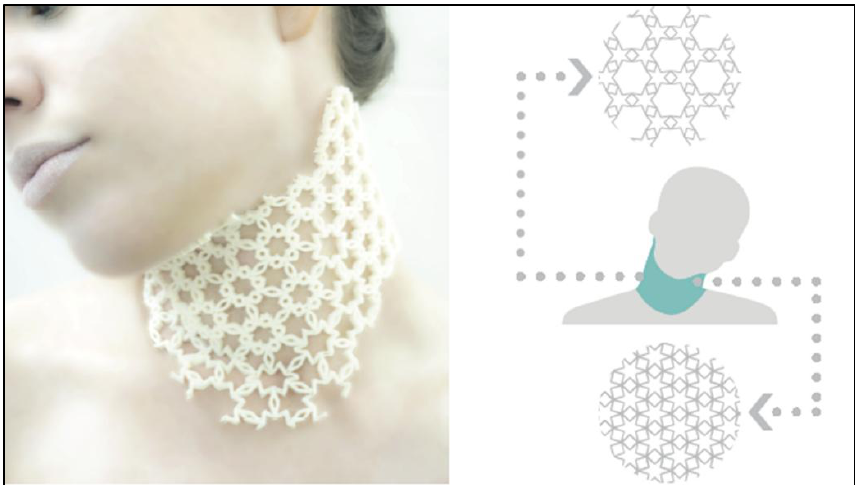
Figure 19. Adaptation of the structure to neck movements